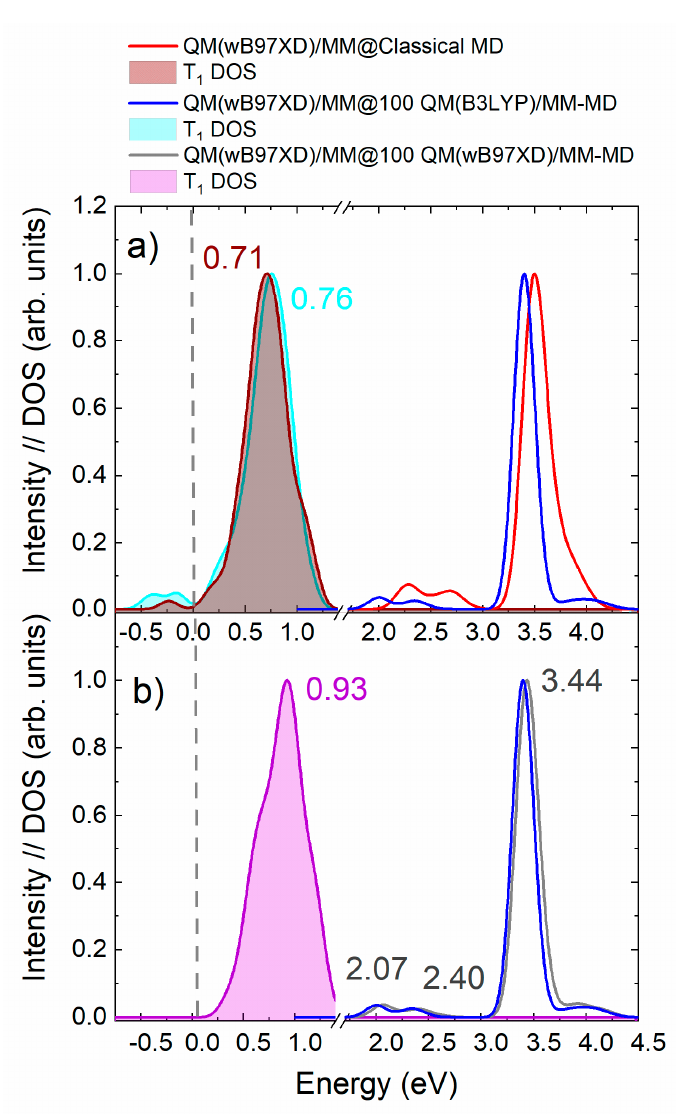
Figure 5. ( a ) Density of states (DOS) of the first triplet excited state T 1 of mTHPC and the corresponding absorption spectrum obtained with the QM(wB97XD)/MM@Classical-MD (red curve for the absorption spectrum and wine for the DOS) and the QM(wB97XD)/MM@100-QM(B3LYP)/MM-MD approaches (blue curve for the absorption spectrum and cyan curve for the DOS). The centre of the T 1 DOS is also reported in eV. ( b ) Absorption spectrum obtained with the QM/MM-MD sampling using B3LYP (blue) and wB97XD (grey) in the QM part. The DOS for the first triplet excited state calculated with the QM(wB97XD)/MM@100-QM(wB97XD)/MM-MD and the value at its centre is reported in purple.